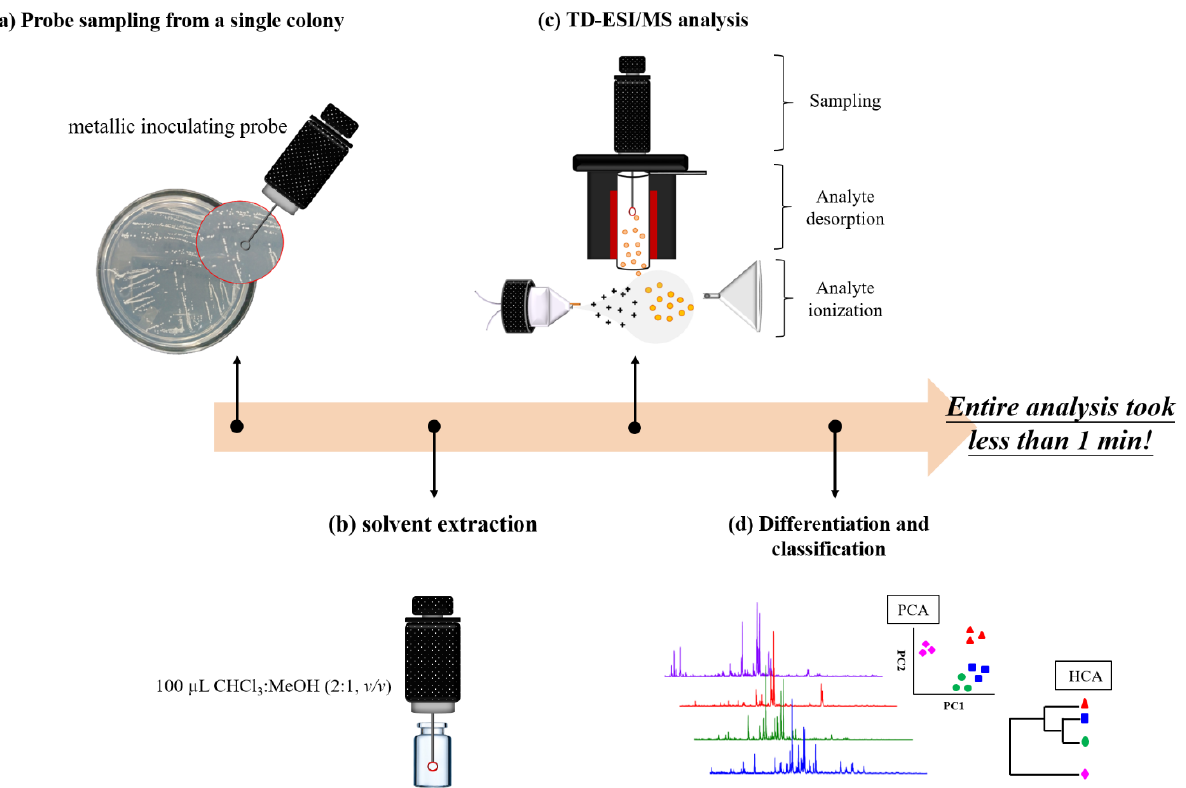
Figure 1. Analytical processes for the direct characterization of microorganisms: ( a ) a metallic inoculating probe was used to collect a single colony of bacterial species on a Petri dish, ( b ) analytes on the probe was extracted with organic solvent; ( c ) analytes on the probe were thermally desorbed and ionized in a TD-ESI source; and ( d ) mass spectral data of the corresponding bacteria were acquired followed by PCA and HCA. The metallic inoculating probe was then cleaned up by a flame from handheld butane torch. The entire analysis took less than 1 min.